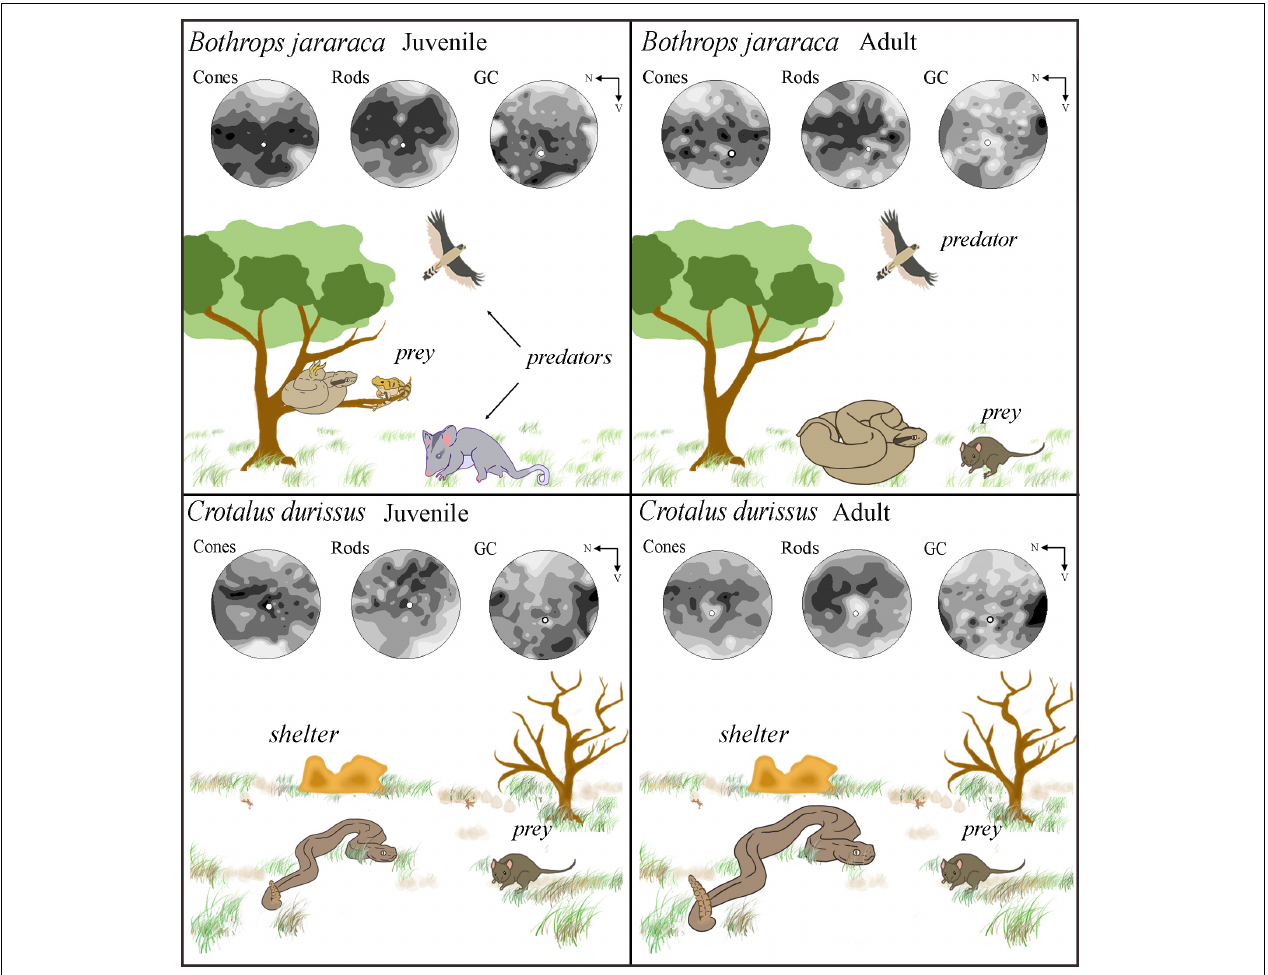
FIGURE 11 | Schematic diagram illustrating the niche occupied by adults and juveniles of Bothrops jararaca and Crotalus durissus , and the distribution of neurons in the retinas of each species. (Upper panel) B. jararaca inhabits forested areas and has ontogenetic changes in diet, behavior, and microhabitat occupied. Juveniles are arboreal, feed on ectothermic prey (attracted by caudal luring), and are susceptible to predation pressure coming from different directions. A higher density of cones and GCL cells in the ventral retina might benefit the view of aerial predators under photopic conditions. A higher density of rods in the ventral retina might favor the view of terrestrial predators in the lower visual field under scotopic conditions. Adults are terrestrial and actively hunt for endothermic prey. Cones and rods are distributed in poorly defined visual streaks, and GCL cells have higher densities in the temporal retina. These specializations might benefit the panoramic view of the environment under photopic and scotopic conditions and of strike performances. (Lower panel) Adults and juveniles of C. durissus occupy open environments (Cerrado) and feed on endothermic prey. In both, cones form poorly defined visual streaks that might benefit scanning the environment to search for shelters for body temperature control during the day to avoid overheating, a usual behavior in snakes that occupy open areas. The higher density of rods in the dorsal retina might favor foraging behavior at scotopic conditions. The peak density of GCL cells in the temporal retina might benefit the view of the frontal field and favor strike performances. N, nasal; V,